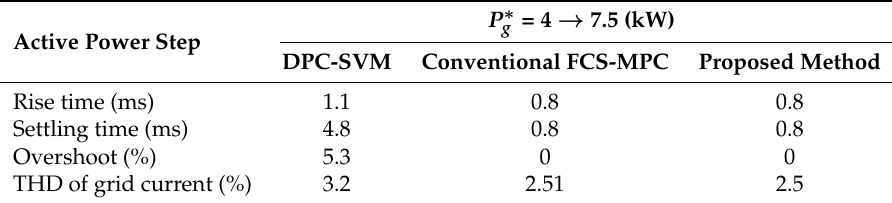
Figure 8. The transient responses of active and reactive powers. Table 4. Comparative studies of transient performance for three